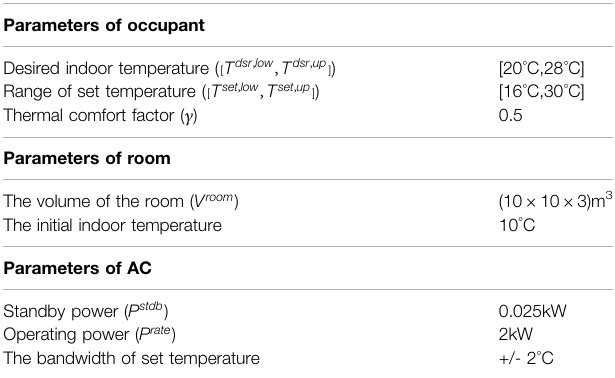
TABLE 1 | Settings of major parameters in the home